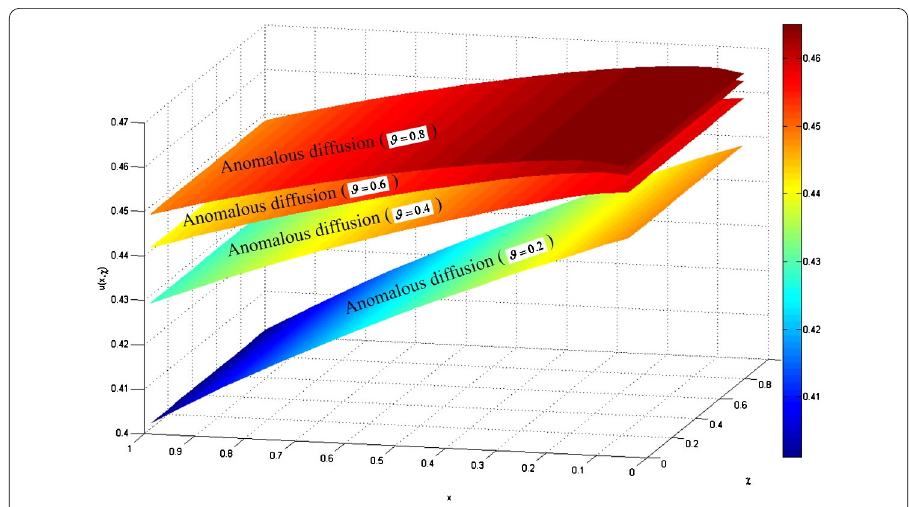
Figure 4 Comparisons of anomalous diffusion processes with different fractional